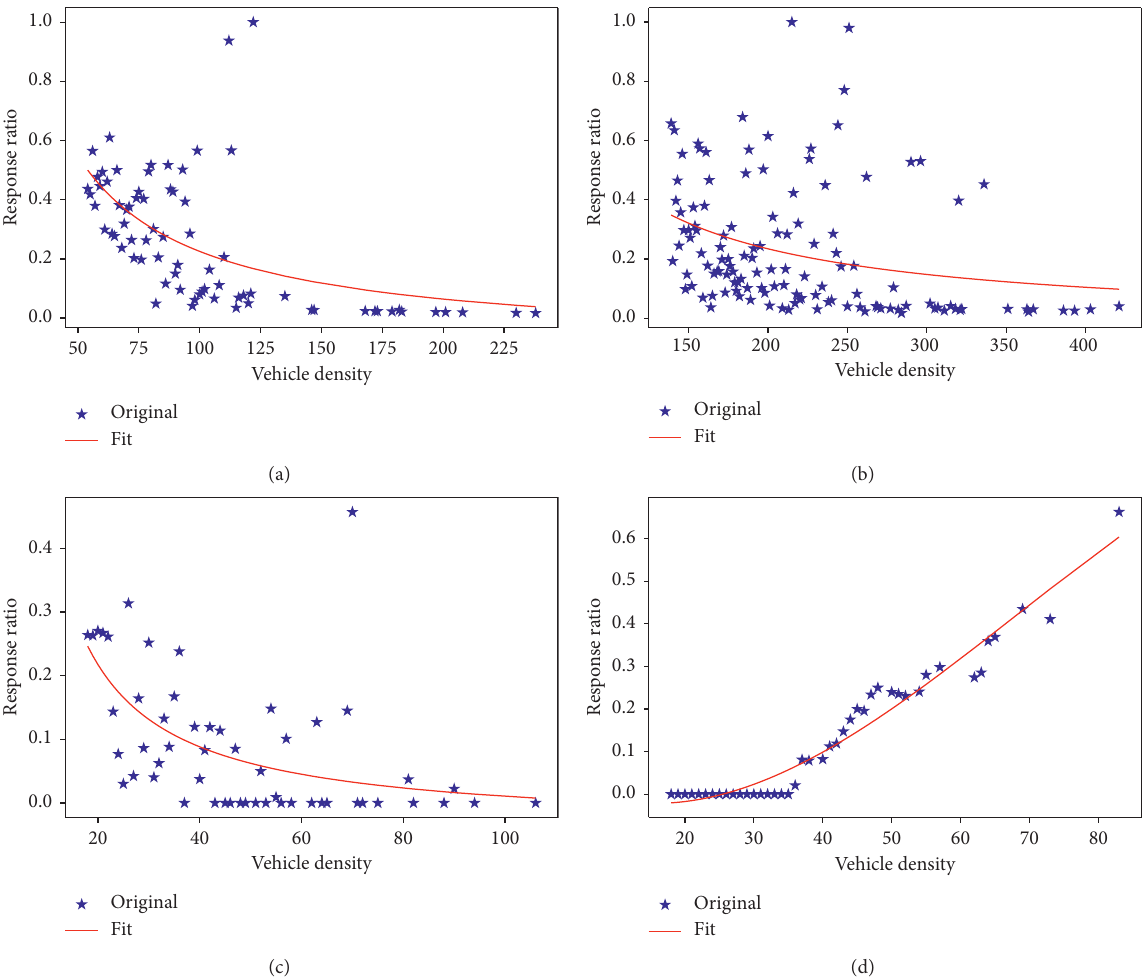
Figure 5: The matching degree varies with taxi density. (a–d) Beijing, Shanghai, Xi’an, and Guangzhou, respectively. The blue stars are original average values, and the red curves are trend fitting curves. The X -axis represents the number of taxis per unit space, and the Y -axis represents the matching